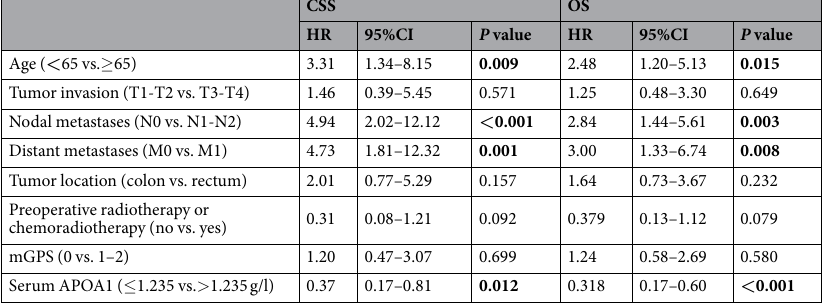
Table 4. Multivariate analysis of 60 month cancer-specific survival (CSS) and overall survival (OS) of CRC patients. Abbreviations: CI: confidence interval; HR: hazard